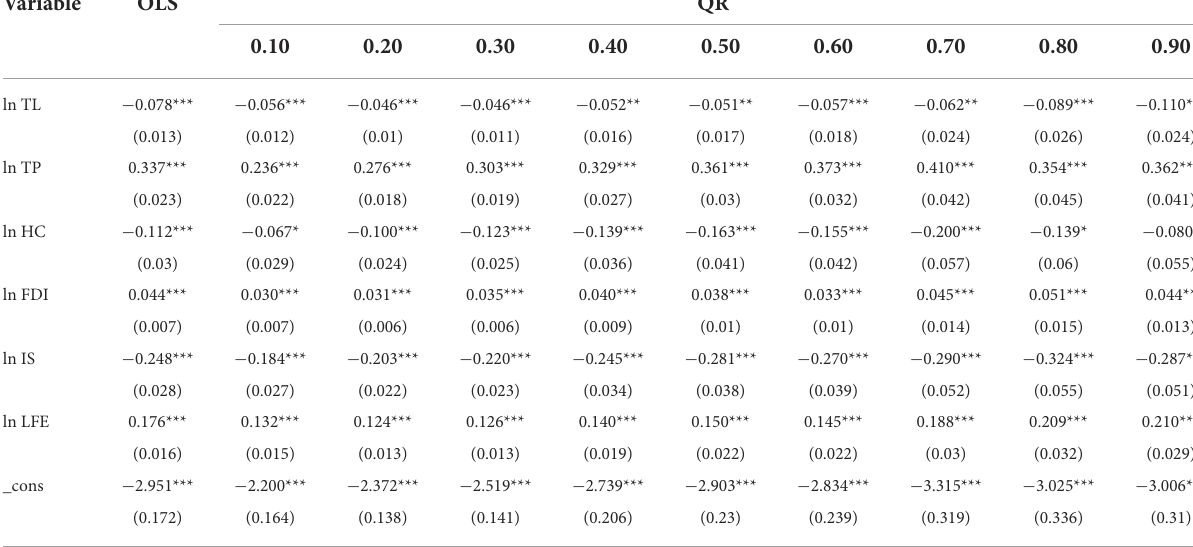
TABLE 5 Least squares method (OLS) and quantile regression (QR) estimation results.